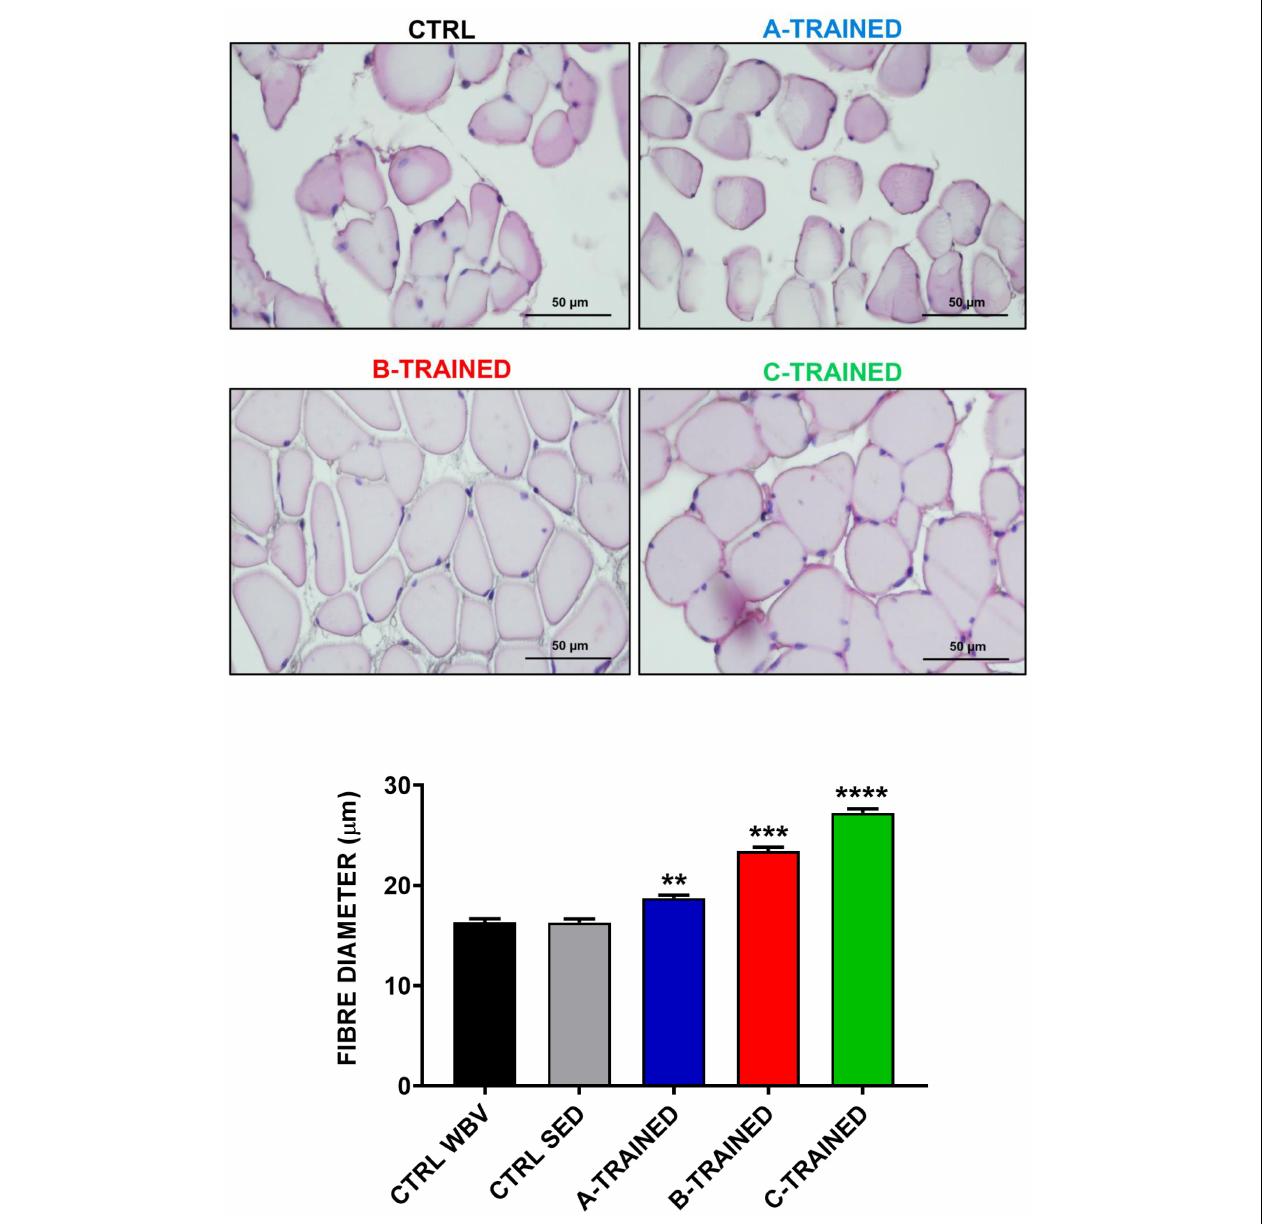
FIGURE 2 | Evaluation of muscle fiber diameter following whole body vibration (WBV) training by histomorphometric analysis. The upper four panels show a representative section of muscle tissue from each experimental group (scale bar, 50 µ m). The lower panel shows the mean value of the muscle fibers diameter in CTRL WBV (black bar, n = 150), in CTRL SED (gray bar, n = 150), in A-TRAINED (blue bar, n = 150), in B-TRAINED (red bar, n = 150), and in C-TRAINED (green bar, n = 150) groups. Note that a significant increase in muscle fiber diameter was found in the trained groups compared with the control groups (CTRL WBV and CTRL SED vs A-TRAINED, ** p < 0.01; CTRL WBV and CTRL SED vs B-TRAINED, *** p < 0.001; and CTRL WBV and CTRL SED vs C-TRAINED, **** p <